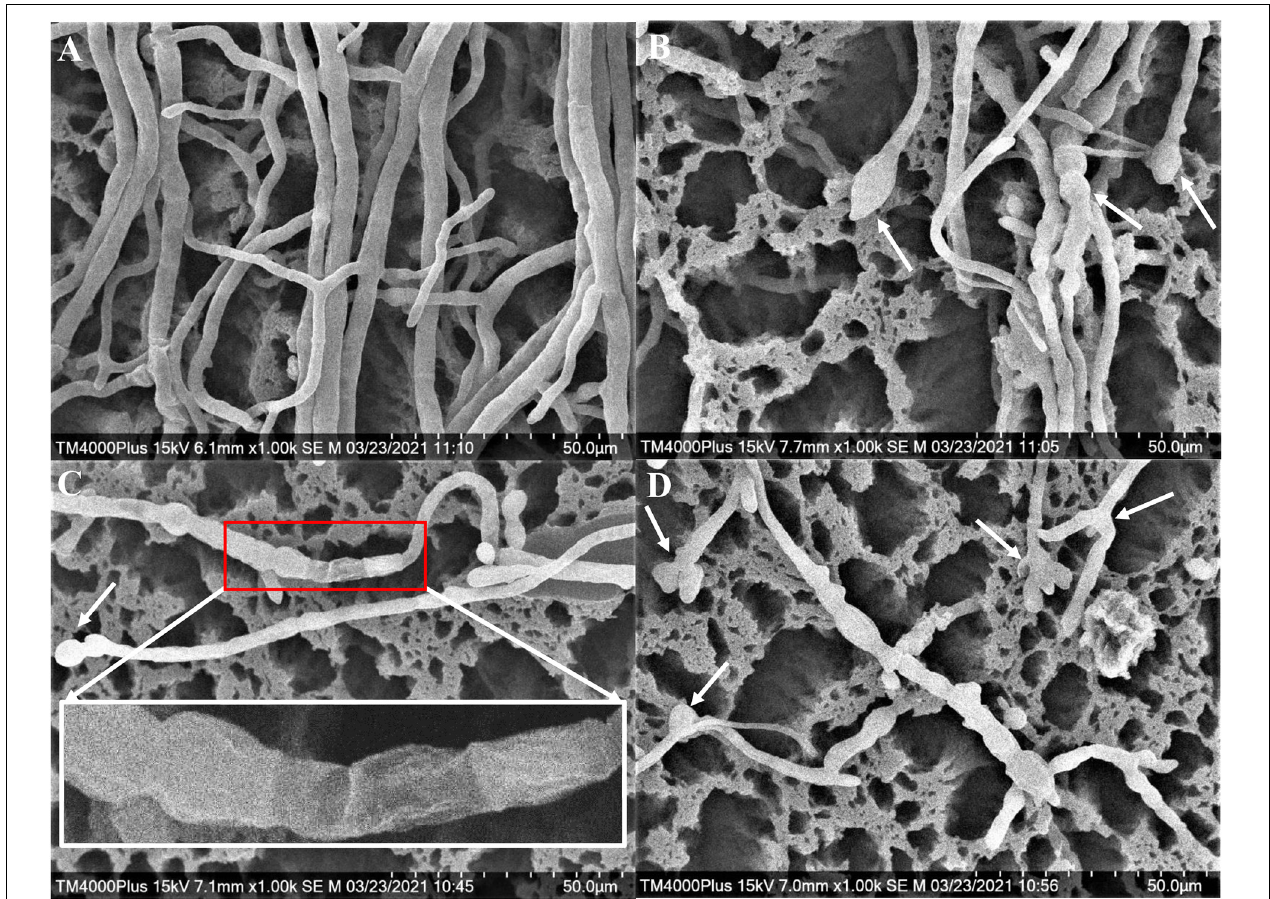
FIGURE 4 | Mycelial morphology of Foc TR4 observed under SEM. (A) Mycelial characteristics of Foc TR4 in the absence of stain H3-2 extracts. (B–D) Mycelial morphology of Foc TR4 treated with 25 µ g/ml of strain H3-2 extracts. The arrows indicate damaged mycelia of Foc TR4 in the presence of strain H3-2